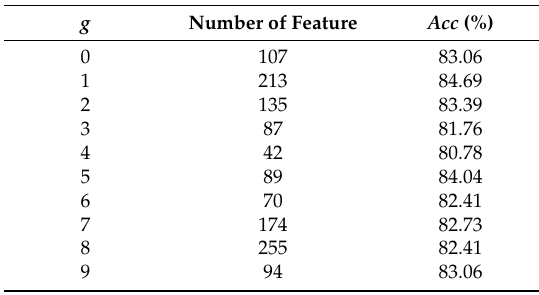
Table 1. The maximum Acc and the corresponding number of feature at different g